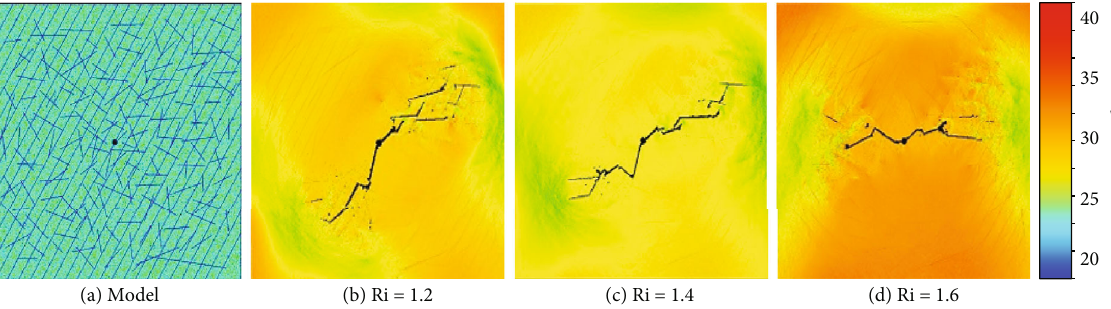
Figure 25: Hydraulic fracture in variable in situ stress conditions [55].